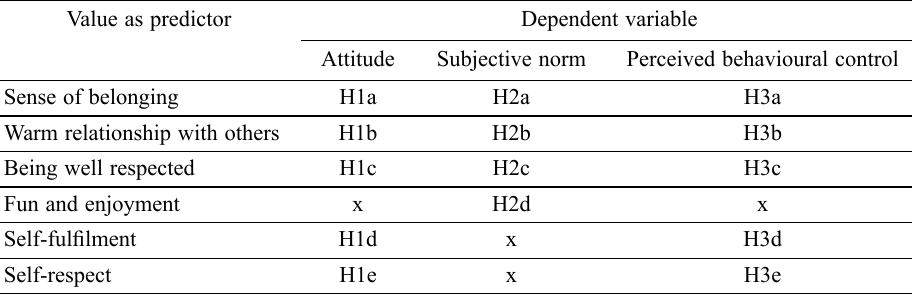
Table 1. Detailed hypotheses of values as significant positive predictors of attitude, subjective norms and perceived behavioural control in relation to